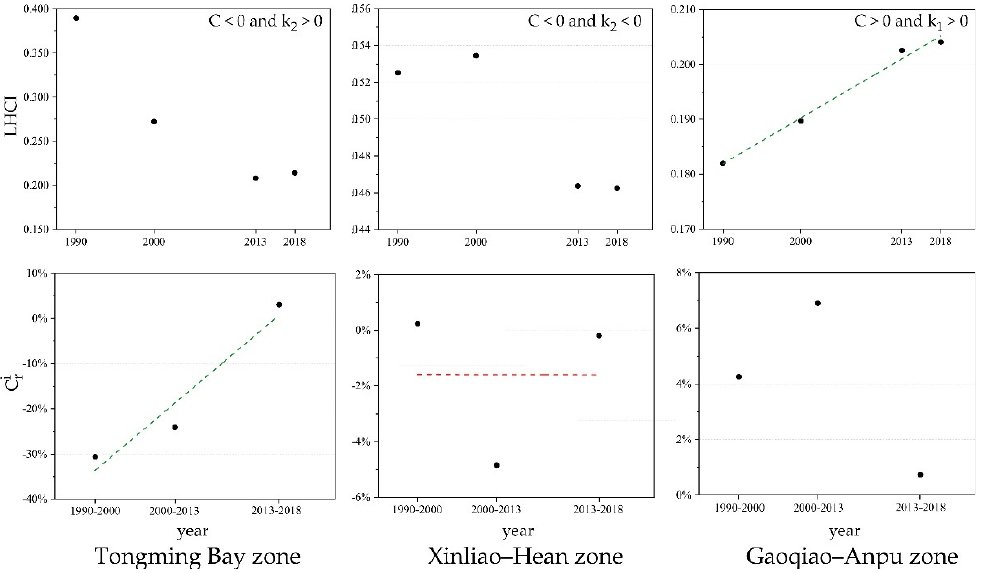
Figure 5. The LHCI and C r in Tongming Bay, Xinliao–Hean, and Gaoqiao–Anpu zones from 1990 to 2018. (The red dotted line represents the decreasing trend (k < 0), and the green dotted line represents the increasing trend (k >